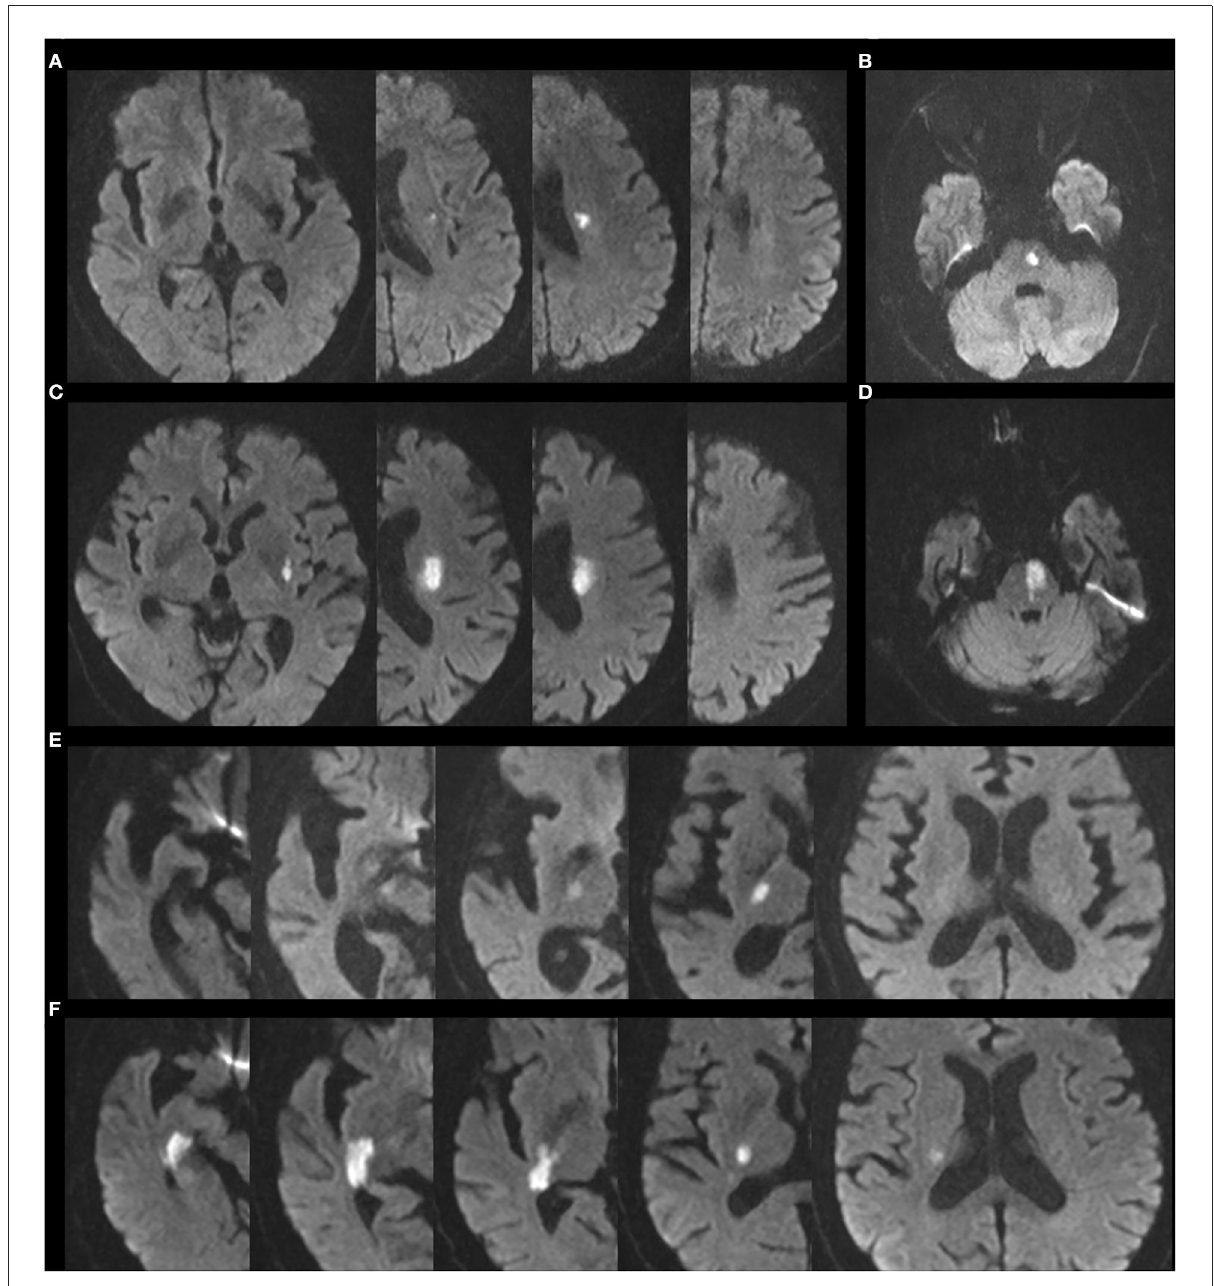
FIGURE1 Representative images of BAD and CSVD lesion supplied by LSA, AChA, and PPA. (A) CSVD lesion supplied by LSA. (B) CSVD lesion supplied by PPA. (C) BAD lesion supplied by LSA. (D) BAD lesion supplied by PPA. (E) CSVD lesion supplied by AChA. (F) BAD lesion supplied by AChA.